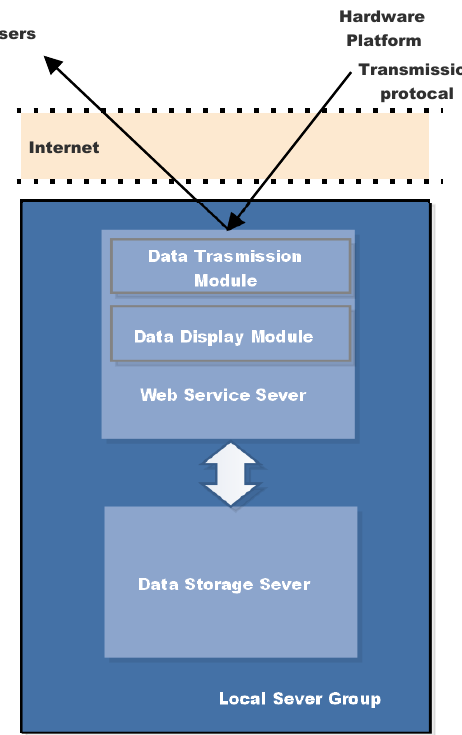
Figure 9. Local Server Group